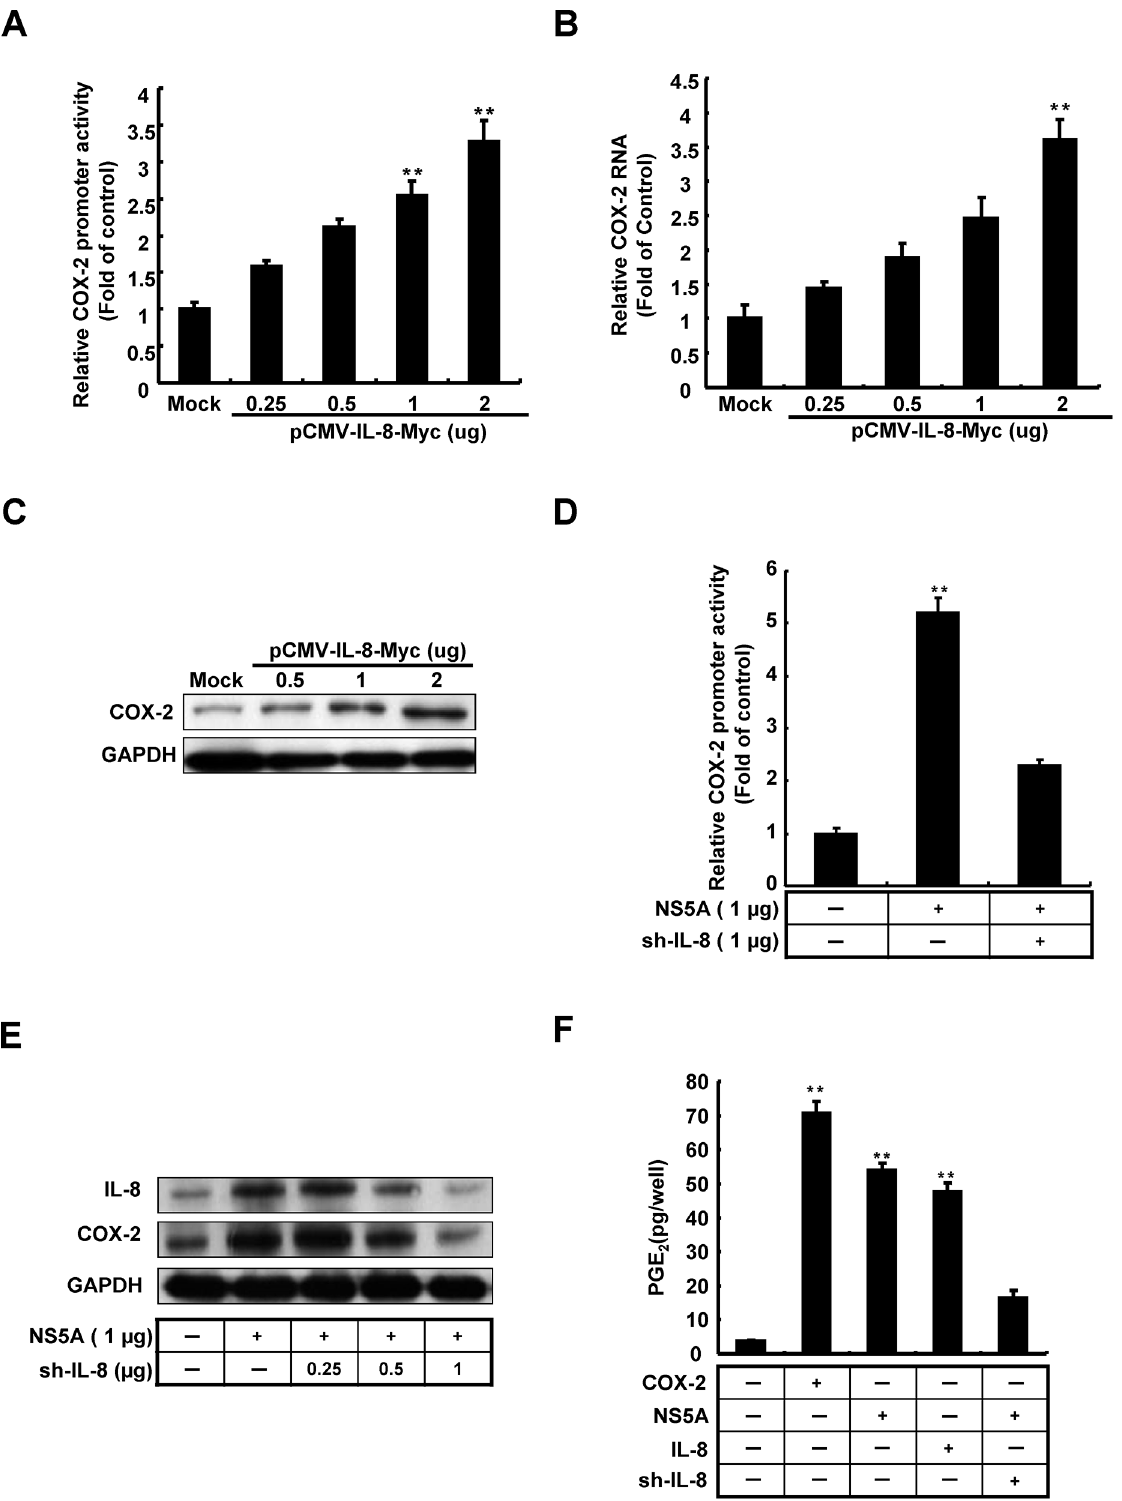
Fig 3. Analysis of the role of IL-8 in the regulation of COX-2 expression mediated by HCV. Induction of COX-2 (A) promoter activity, (B) RNA levels, (C) protein expression in a dose-dependent manner. The Huh7 cells were co-transfected with pCOX-2-Luc and different amounts of pCMV-IL-8-Myc (0 – 2 μ g). After incubation for 3 days, the cell lysates were subjected to luciferase activity assay to measure the induction of COX-2 promoter by Steady-Glo luciferase